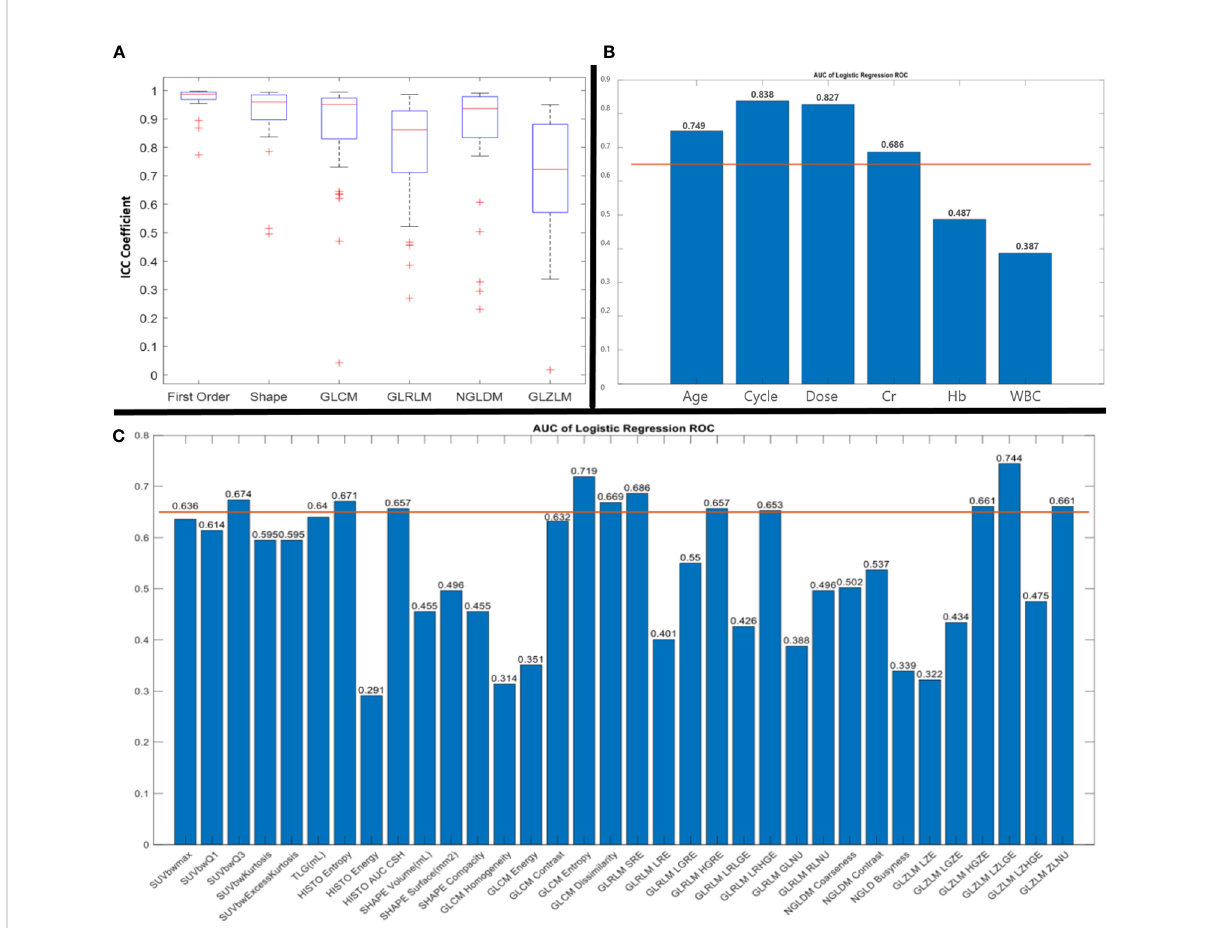
FIGURE 1 Results of intraclass correlation coef fi cient (ICC) (A) and receiver operating characteristic (ROC) curve analysis with area under the curve (AUC) of clinical parameters (B) and radiomic features (C) . AUC more than 0.65 was considered for further